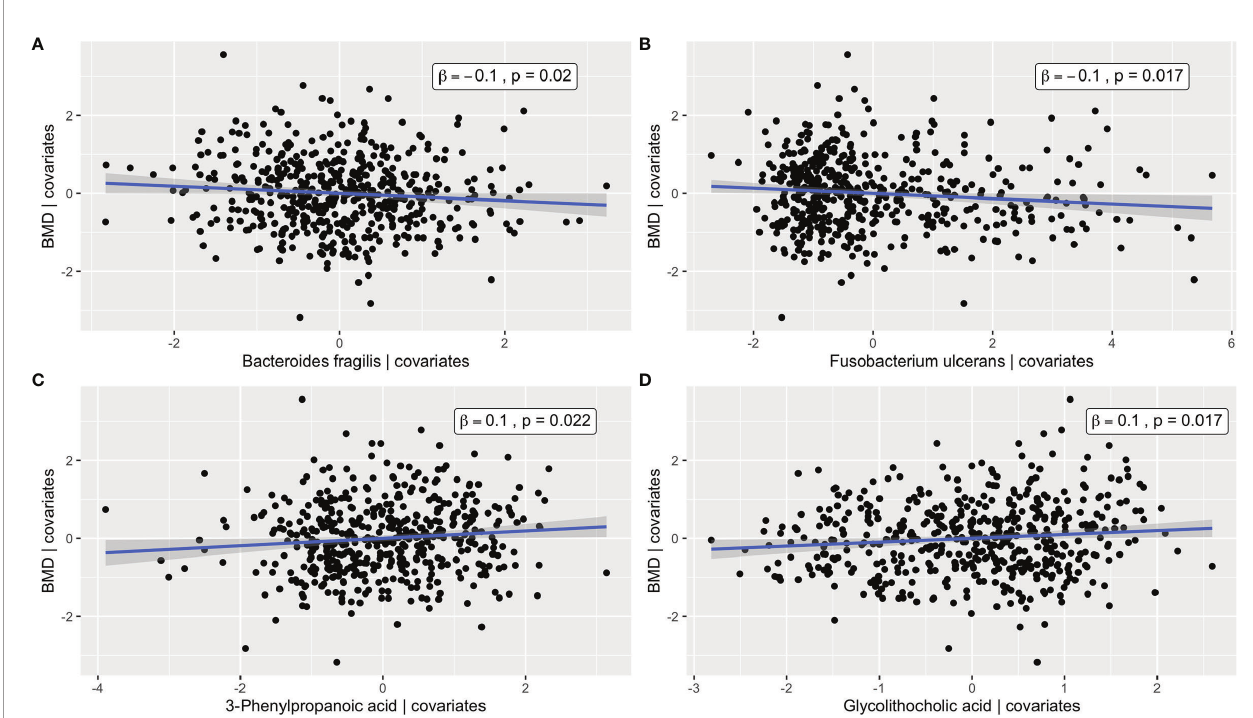
FIGURE 4 | Added variable partial regression plots for (A) Bacteroides fragilis , (B) Fusobacterium ulcerans , (C) 3-Phenylpropanoic acid, and (D) Glycolithocholic acid. The plots illustrate the relationships between the abundance of a given microbe/metabolite and BMD after adjustment for age, BMI, exercise, years since menopause, FSH, and estradiol. The x-axes correspond to the residuals from regressing the microbe/metabolite on the covariates. The y-axes correspond to the residuals from regressing the phenotype on the covariates. The blue line represents the line of best fi t from linear regression, and the corresponding con fi dence interval is shown in